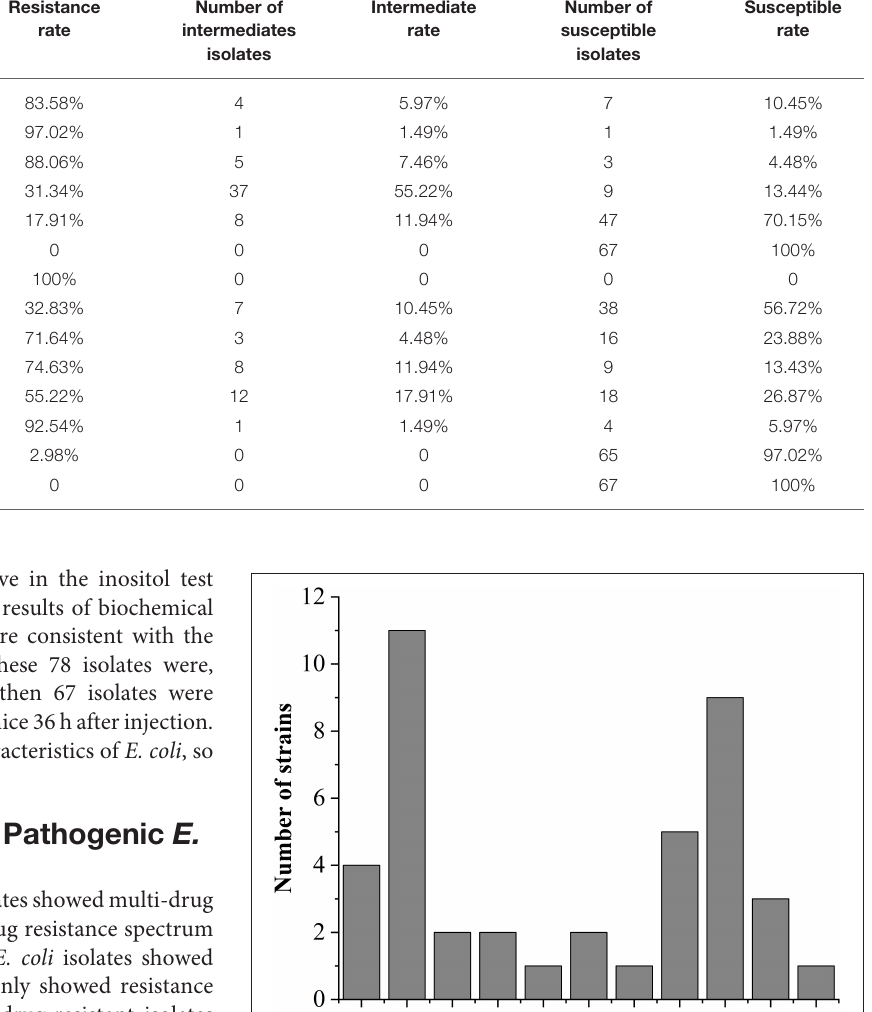
Resistance rate